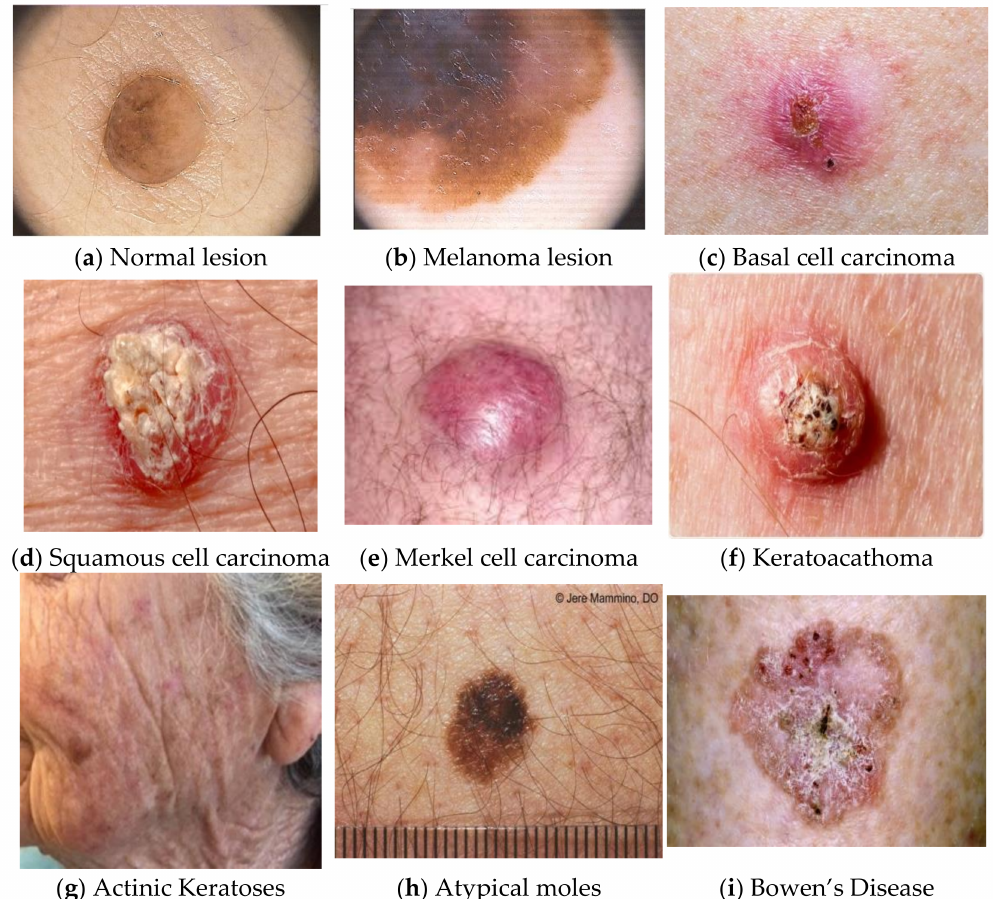
Figure 1. Examples of normal lesions and melanoma in skin lesion images [4]. ( a ) Normal lesion, ( b ) Melanoma lesion, ( c ) Basal cell carcinoma, ( d ) Squamous cell carcinoma, ( e ) Merkel cell carcinoma, ( f ) Keratoacathoma, ( g ) Actinic Keratoses, ( h ) Atypical moles, ( i ) Bowen’s